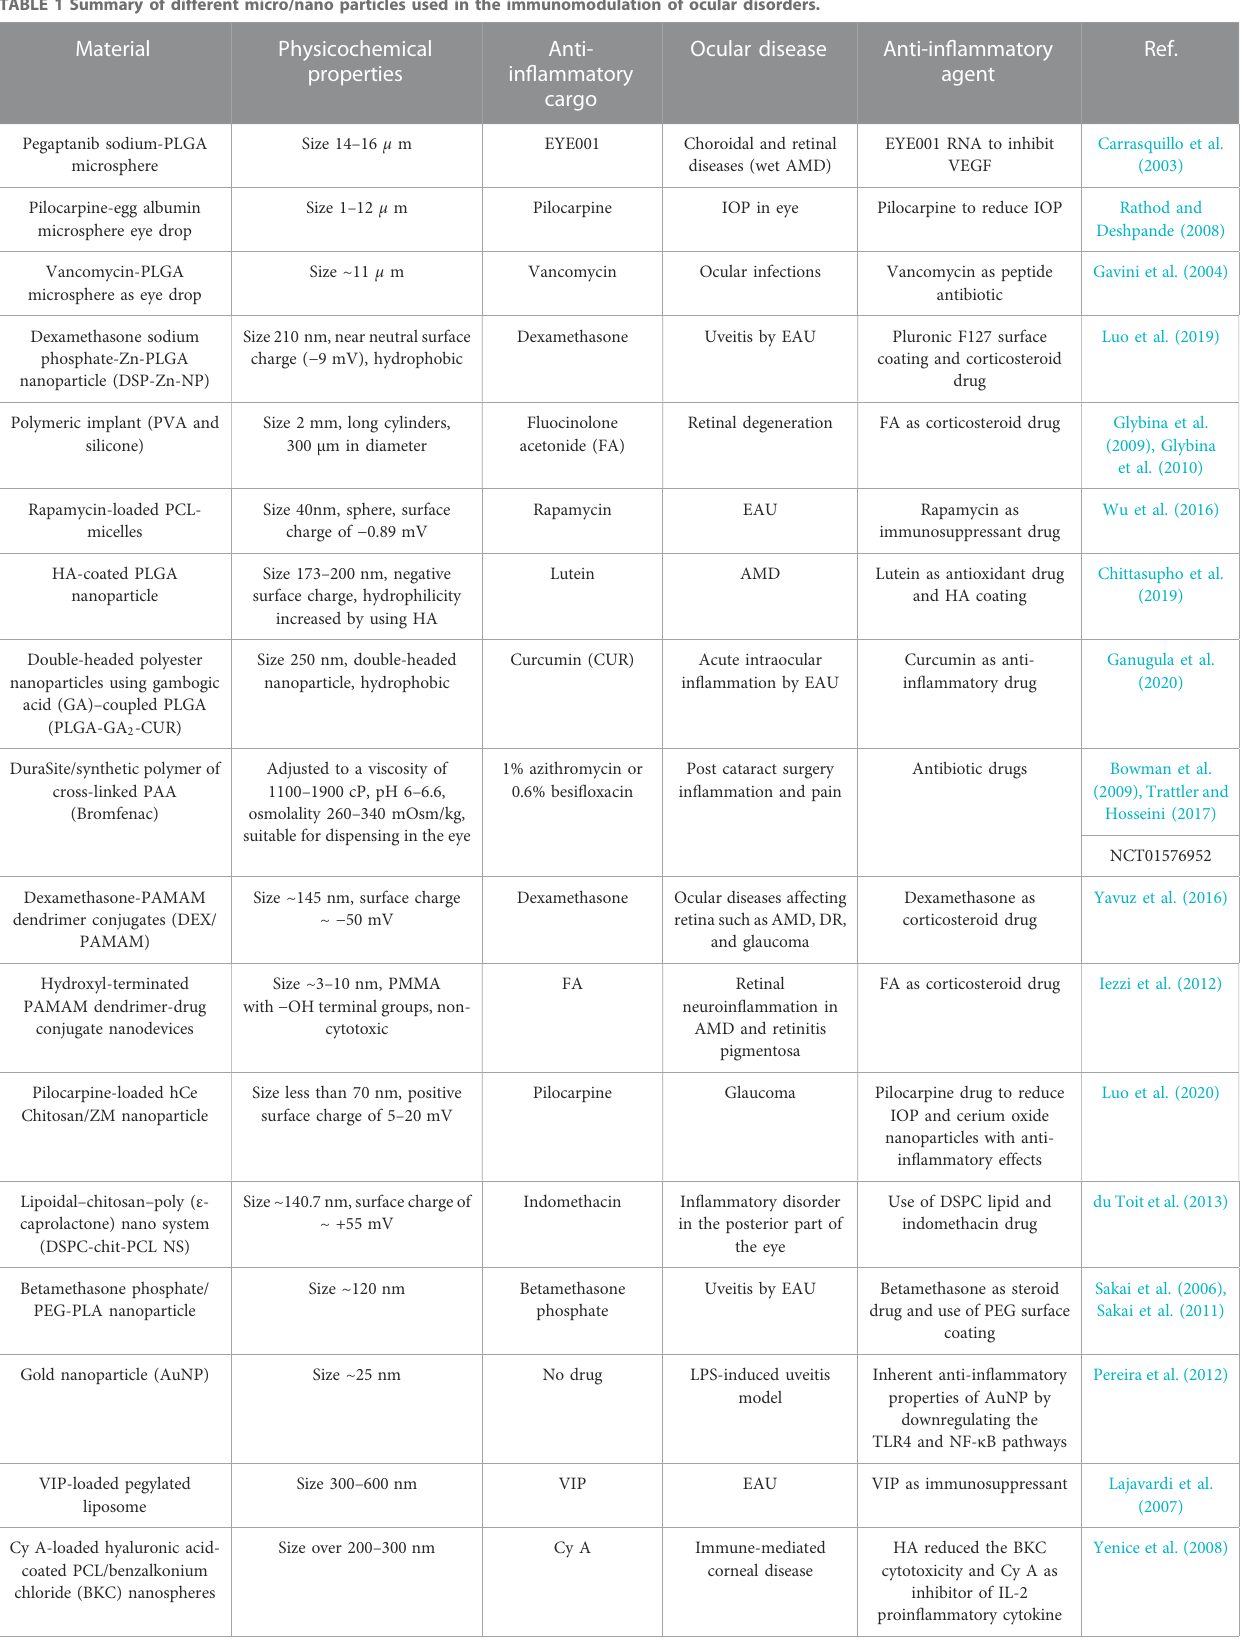
TABLE 1 Summary of different micro/nano particles used in the immunomodulation of ocular